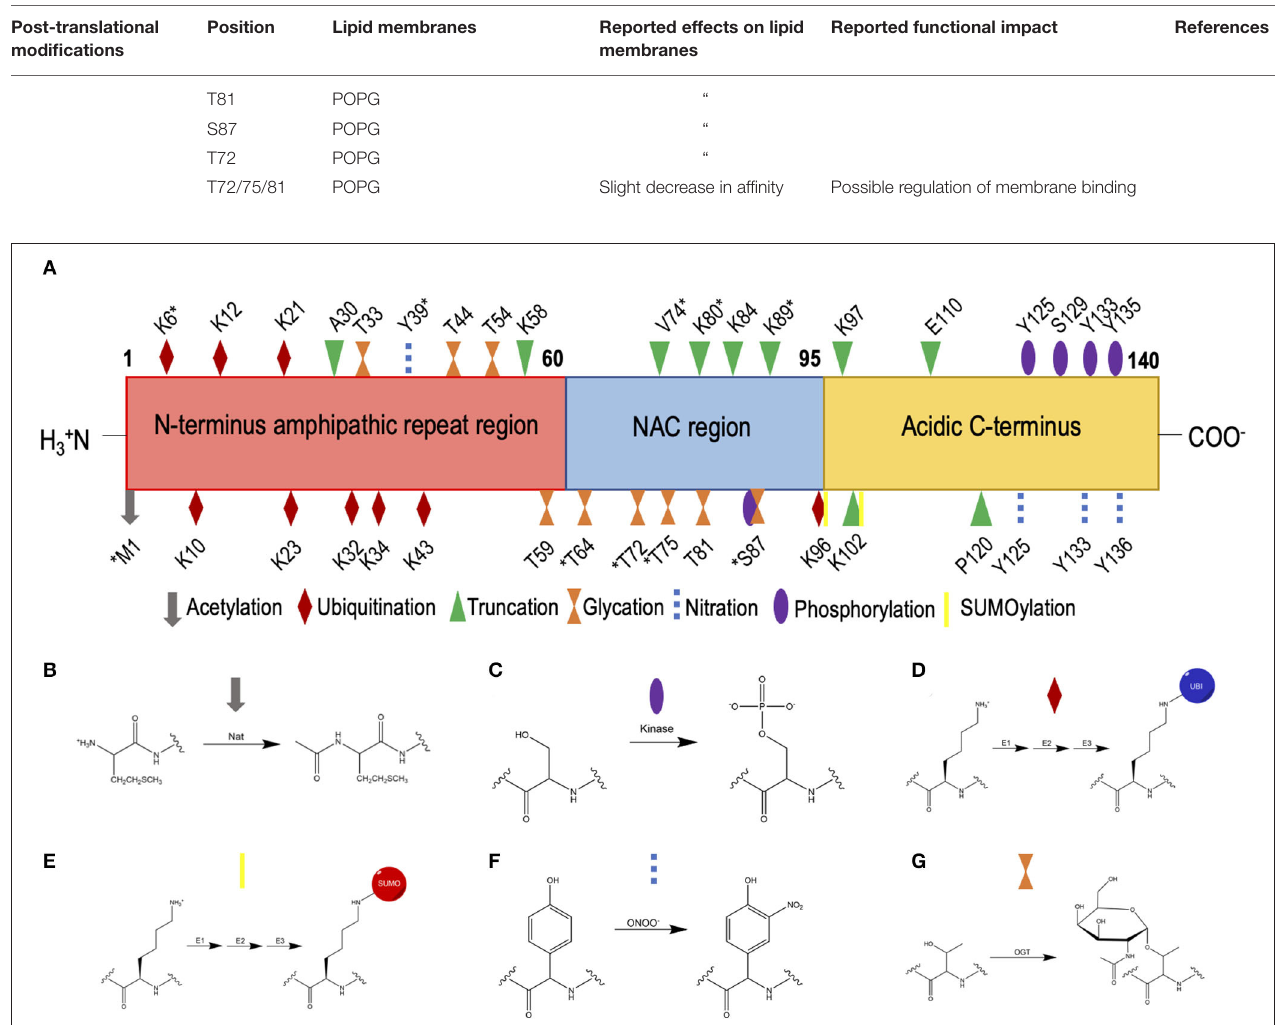
FIGURE 4 | List of currently known post-translational modifications of α -synuclein. (A) The amino acid sequence of α -synuclein comprises an N-terminal amphipathic region (residues 1-60), a non-A β component (NAC) region (residues 61-95), and an acidic C-terminal region (residue 96-140). Post-translation modification sites are labelled; *indicates post-translation modifications within low-solubility areas using CamSol ( 70). (B) N-terminal acetylation, which is carried out by N-acetyltransferases (Nat). (C) Phosphorylation, which occurs by the esterification by a phosphate group of the side-chain hydroxyl moiety of serine or threonine residues; shown here is the phosphorylation of a serine residue. (D) Ubiquitination, where ubiquitin is added to lysine residues via an isopeptide bond, catalysed by sequential action of 3 enzymes, E1 (ubiquitin-activating enzyme), E2 (ubiquitin-conjugating enzyme) and E3 (ubiquitin ligase). (E) SUMOylation, where SUMO is added to lysine residues via a thioester bond, catalysed by sequential action of 3 enzymes, E1 (SUMO-activating enzyme), E2 (SUMO-conjugating enzyme), and E3 (SUMO ligase). (F) Nitration, where tyrosine residues are nitrated by peroxynitrite; the phenolic R group is converted to 3-nitro-tyrosine, by the addition of a nitro (NO 2 ) group onto the ortho position of the ring by peroxynitrite. (G) O-GlcNAcylation, where the enzyme O-GlcNAc transferase (OGT) catalyses the addition of N-acetylglucosamine (GlcNAc) to the hydroxyl group (O-linked) of the side-chains of serine and threonine residues; shown here is the O-GlcNAcylation of a threonine residue.